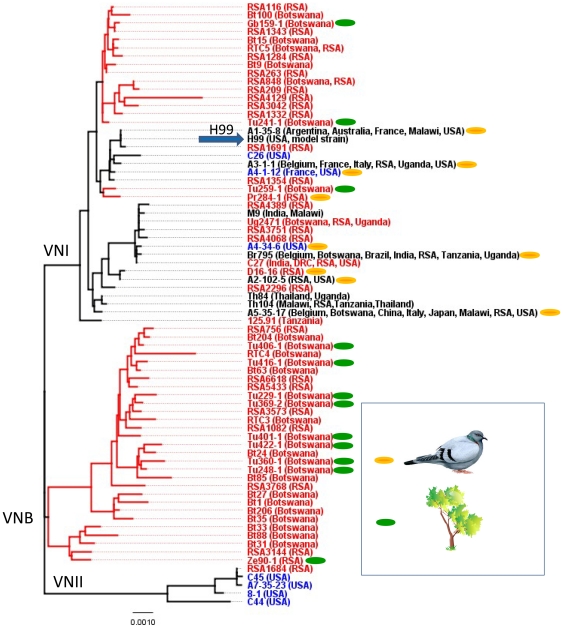
This unrooted dendrogram depicts the genetic relationships of MLST genotypes among isolates of C. neoformans var. grubii.DNA sequences of eight loci were concatenated (totaling 4,443 base pairs) and analyzed with the neighbor joining method using uncorrected (“p”) genetic distances. The three major subpopulations or divergent clades of C. neoformans var. grubii, VNI, VNII, and VNB, are apparent. Isolates are clone-corrected (i.e., only one strain of each unique genotype is included). For each genotype, the country or countries of origin is/are shown in parentheses (RSA, Republic of South Africa; DCR, Democratic Republic of Congo). Strains that are unique to Africa are labeled in red, strains that are not found in Africa are labeled in blue, strains that are isolated from Africa and elsewhere are labeled in black. The ecological origin of each strain is indicated by colored ellipses. Green indicates that the strain was isolated from trees and/or soil at the base of trees, and an orange ellipse denotes that the strain was isolated from pigeon feces or soil contaminated with avian feces. Strains without an accompanying green or orange ellipse are clinical isolates that have not been yet been isolated from the environment. In addition, regardless of the ecological source of an isolate, most of the strains or their clones have been isolated from patients. Model strain H99, which is the subject of most molecular studies of C. neoformans, is labeled with arrow [62]. Refer to Table S2 for details about each isolate.